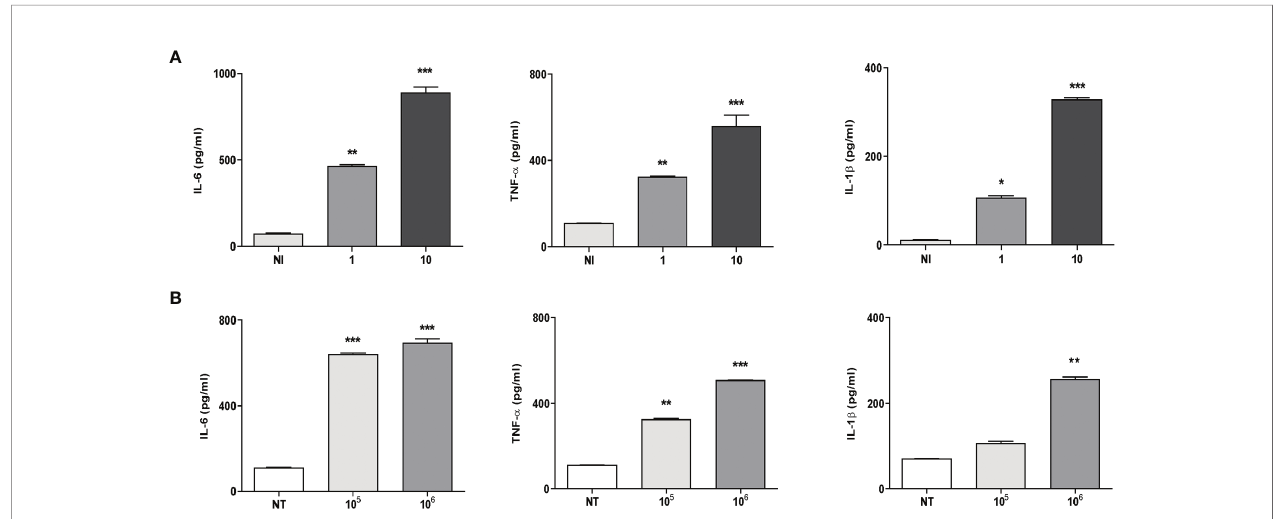
FIGURE 1 | Monocytes produce proin fl ammatory cytokines in response to Kingella kingae infection. THP-1 cells were infected with K. kingae at different multiplicities of infection 1 and 10 (A) or stimulated with HKKk (1 × 10 5 and 1 × 10 6 bacteria/ml (B) . IL-6, TNF- a , and IL-1 b were determined in culture supernatants by ELISA at 24 h post-infection. NI, non-infected; NT, non-treated. The graphics are showing values obtained from three independent experiments. Data are given as mean ± SD. * P < 0.05; ** P < 0.01; *** P < 0.001 versus control (NI and